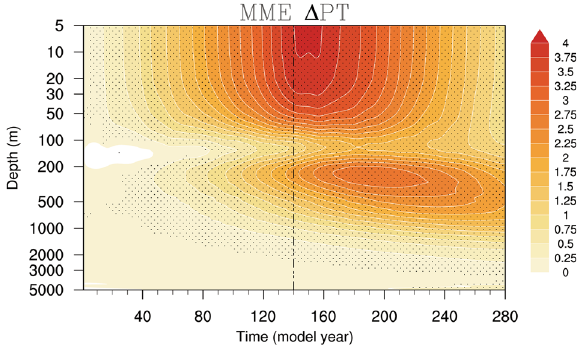
Fig. 10 The response of the oceanic potential temperature. Time evolution of tropical Paci fi c Ocean mean ( − 10.5°S – 10.5°N, 180° – 100°W) potential temperature change ( Δ PT ; unit: °C) pro fi le in CO 2 ramp-up and ramp-down experiments at all depths, based on repeated application of 3-point (1/4, 1/2, 1/4) fi lter with 40 times. Δ PT is relative to the PI. The black dashed line indicates the CO peak year (Year 140). Black dots indicate more than 70% ensemble members agree with the sign of the MME. Note that the vertical depth coordinate is center over the Indian Ocean weakens the SA-Indian Ocean thermal and thus SASM circulation. The uneven enhanced warming leads to anomalous sinking, as well as decreased precipitation over the SASM region directly. Additionally, over the Paci fi c and Indian Ocean sectors, the weakened Walker circulation affects SASM circulation indirectly. It suppresses the rainfall over the MC and increases the rainfall over the TWIO. The suppressed precipitation over the MC triggers an equatorial Rossby wave response to generate an anomalous lower-level anticyclone, which weakens the ascent on the top of the planetary boundary layer, via the effect of Ekman downwelling. The increased rainfall over the TWIO triggers an equatorial Kelvin wave response to hinder water vapor transport to SA. The enhanced IOD-like warming pattern may reinforce the anomalous easterly over the tropical Indian Ocean and further weaken water vapor transport. The combination of the weakened ascent and water vapor transport caused by the enhanced uneven SST warming leads to the asymmetric response of SASM precipitation.